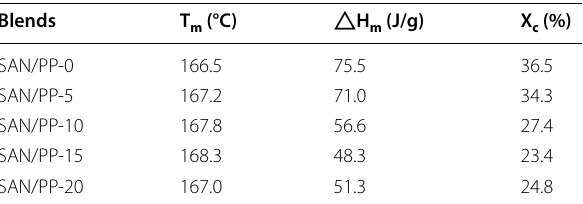
Table 2 Melting and crystallization parameters of pure PP and SAN/PP blends